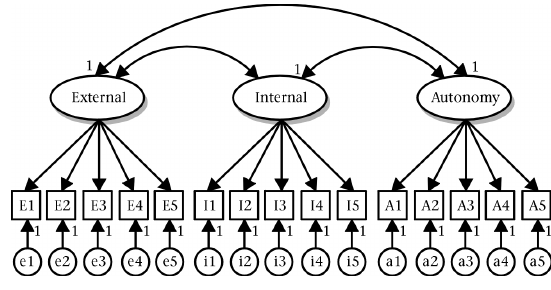
Figure 2: Confirmatory factor analysis model for the Locus of Control